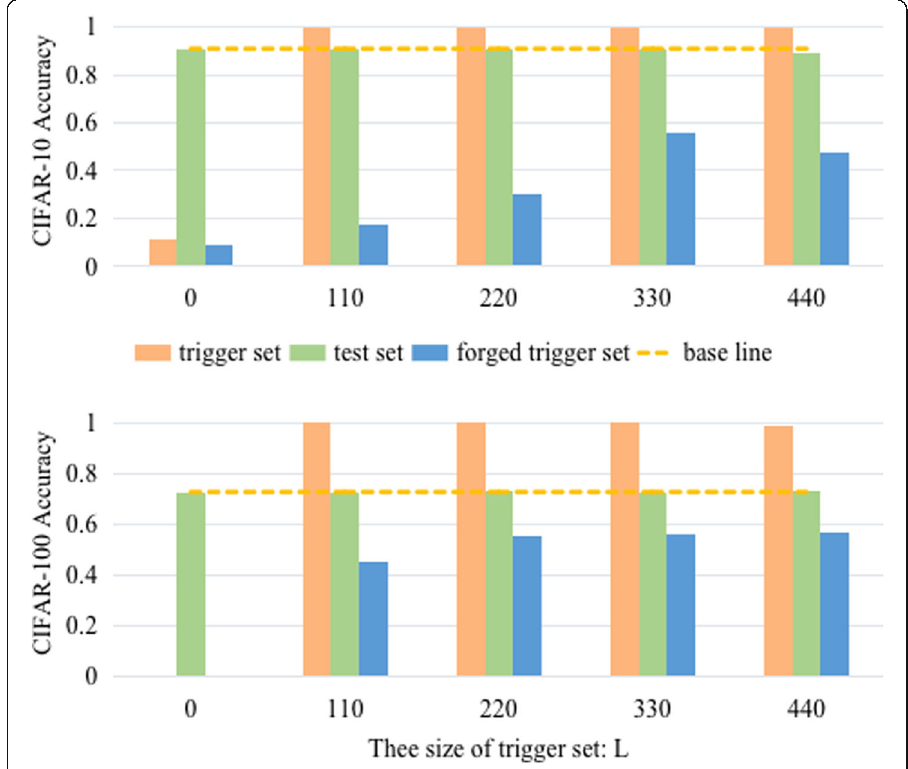
Fig. 2 The effect of increasing the size of the trigger set on the function of resnet18 [13]. The two bar charts above and below respectively represent the experimental results on CIFAR-10 and CIFAR-100. Orange, green, and blue bars are our trigger set, test set, and the attacker ’ s forged trigger